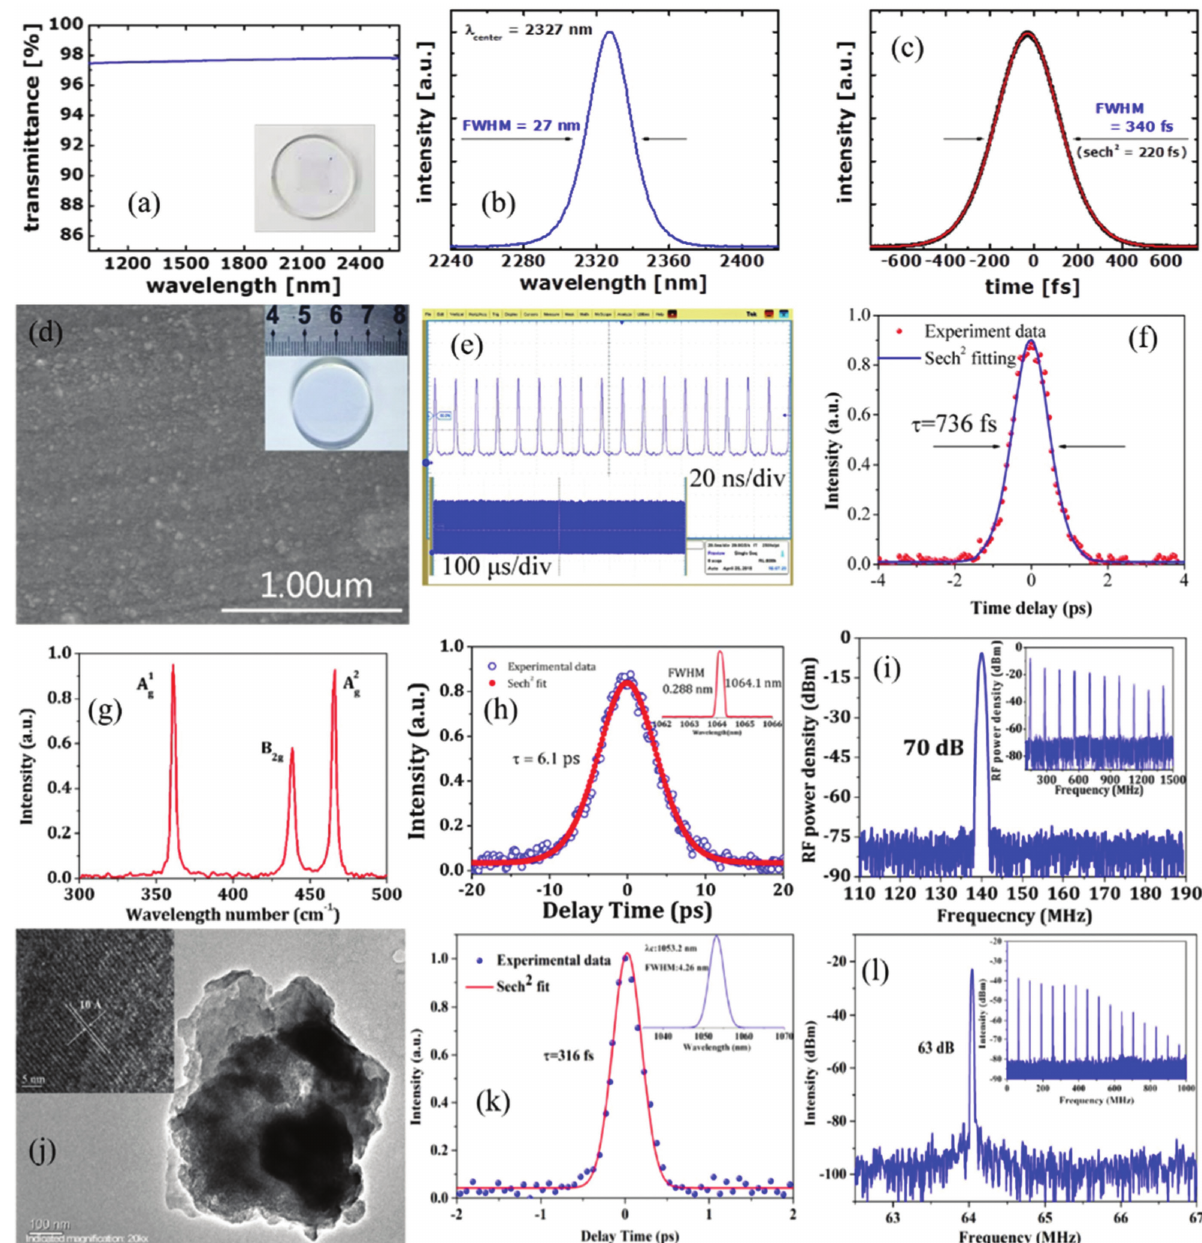
Figure 8: Mode-locked solid-state lasers with layered material-based SAs. (A–C) Graphene. (A) Linear transmission and photo image of graphene SA (inset). (B) Optical spectrum. (C) Autocorrelation trace. Reproduced with permission from Ref. [175]. Copyright 2016, Optical Society of America. (D–F) WS of the SiO substrate (inset). (E) Pulse train. (F) Autocorrelation trace. Reproduced with permission from Ref. [150]. Copyright 2015, Optical 2 Society of America. (G–I) BP. (G) Raman spectrum of BP. (H) Autocorrelation trace and optical spectrum (inset). (I) RF spectrum and wide- range RF spectrum (inset). Reproduced with permission from Ref. [181]. Copyright 2015, Optical Society of America. (J–L) MXene, Ti (T = O, OH, or F). (J) TEM of MXene. (H) Autocorrelation trace and optical spectrum (inset). (I) RF spectrum and wide-range RF spectrum (inset). Reproduced with permission from Ref. [182]. Copyright 2018, Optical Society of